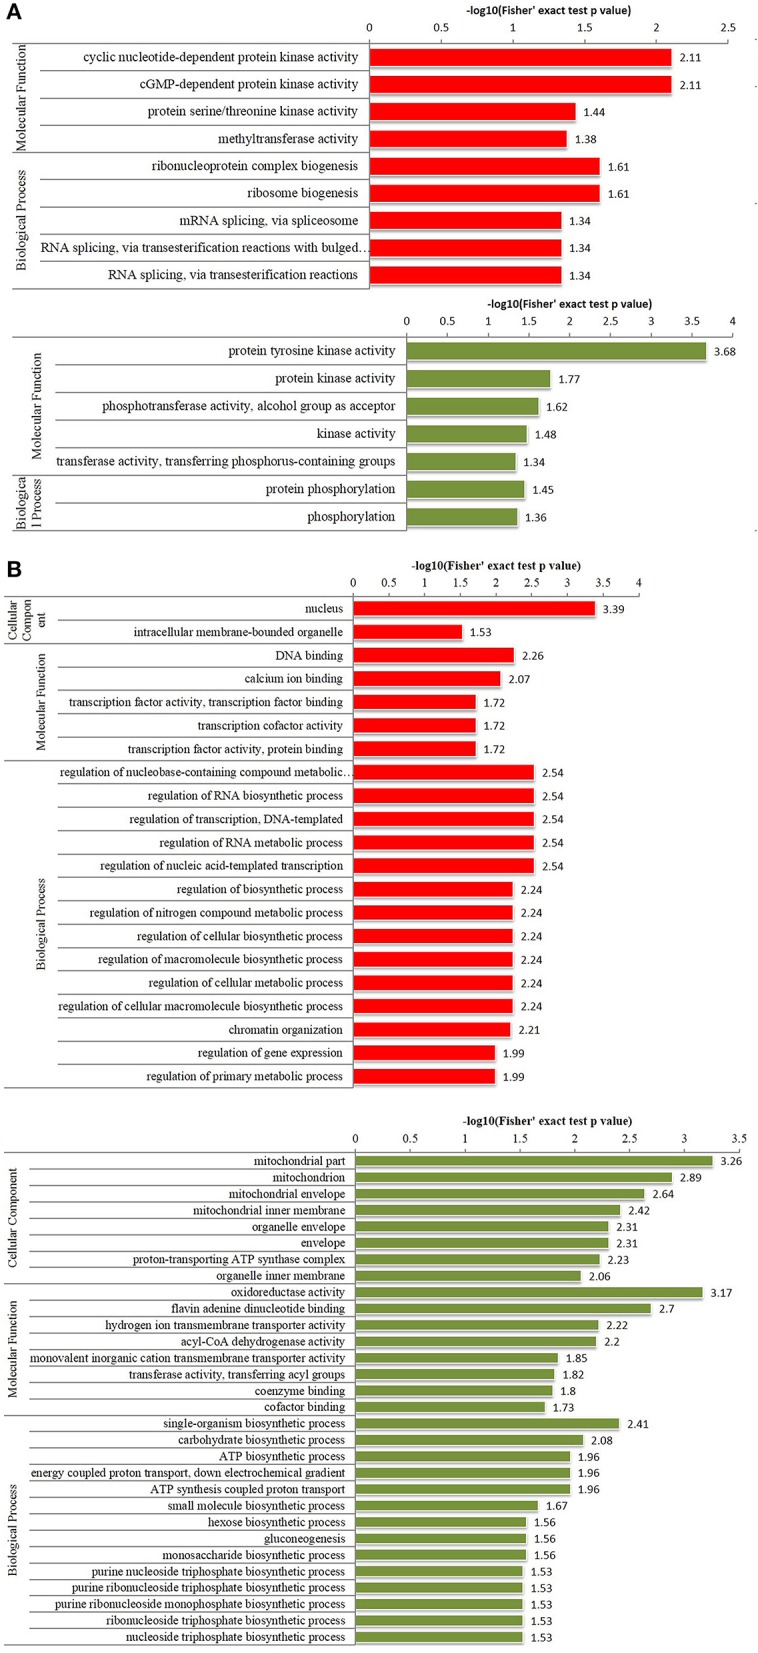
Enriched gene ontology (GO) analysis of differentially phosphorylated and acetylated proteins (p < 0.05). (A) phosphorylation. (B) Acetylation. Red, GO terms of proteins for which the modification was upregulated. Green, GO terms of proteins for which the modification was downregulated.